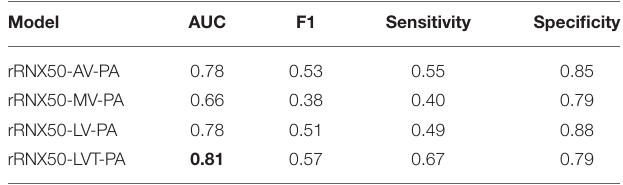
TABLE 5 | Analyzing different voting functions of Chest L-Transformer (classification).